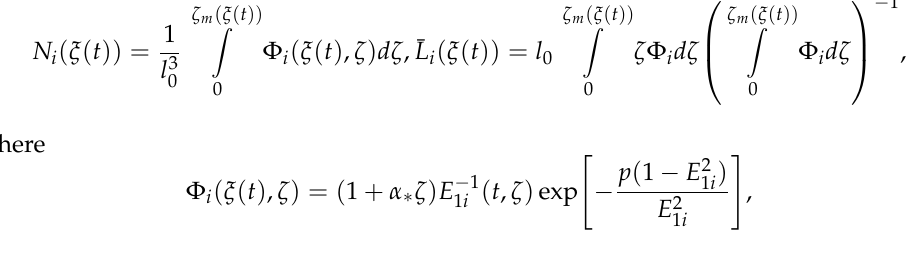
Figure 3. The dimensionless number of crystals n i = N i ( ξ ) ( b ) as a function of dimensionless time t = τ ∆ T = 573 K. The vertical lines show the time of the process when supercooling is totally 0